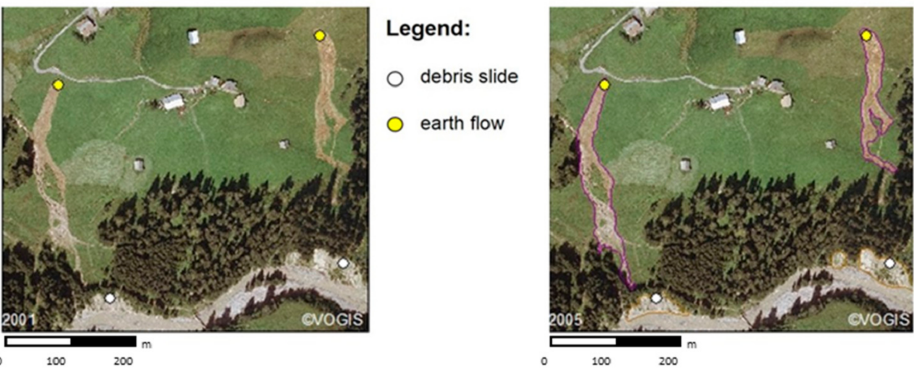
Figure 3. Close-up view of the area of Warth-Teschenberg on the river Lech where two types of landslides (highlighted with purple polygons) were activated in different times (before 2001: white circles and in 2005: yellow circles) (aerial-photos© VoGIS).